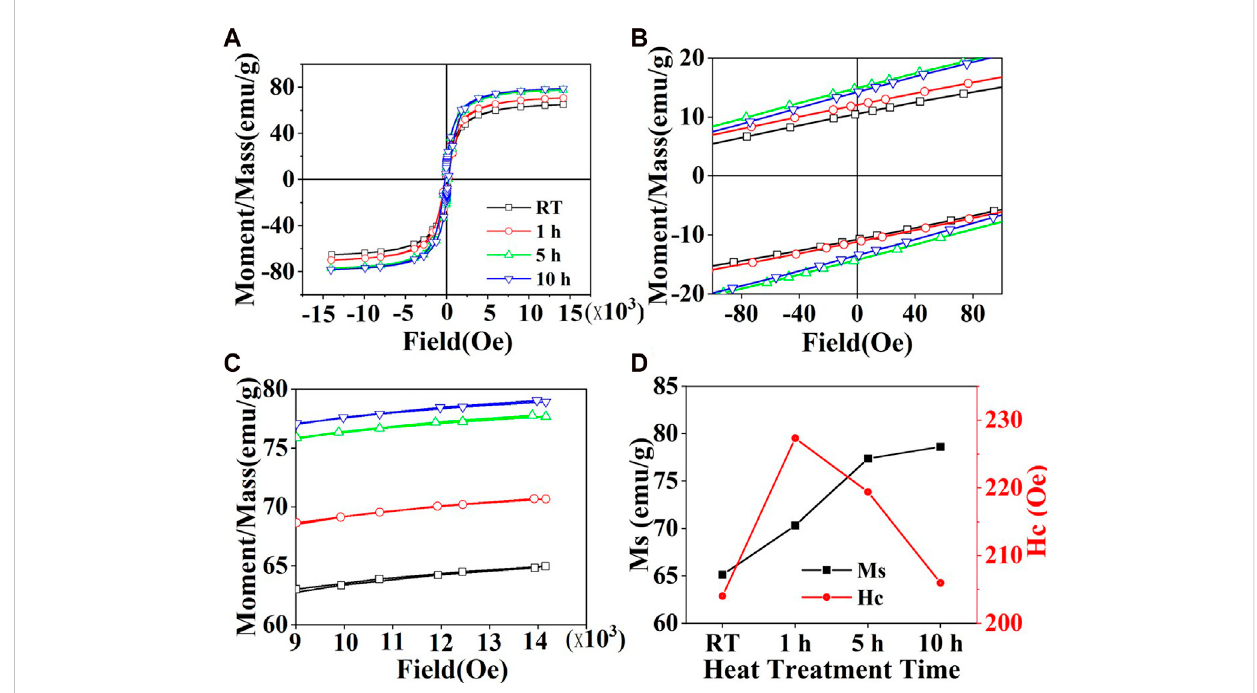
FIGURE 3 Staticmagneticproperties ofFeCoCr powders after heat treatment at400 ° C: (A) hysteresis loop, (B) enlargement ofmagnetizationatlow magnetic fi eld, (C) enlargement of magnetization at high magnetic fi eld, (D) changes in saturation magnetization and coercivity with heat treatment